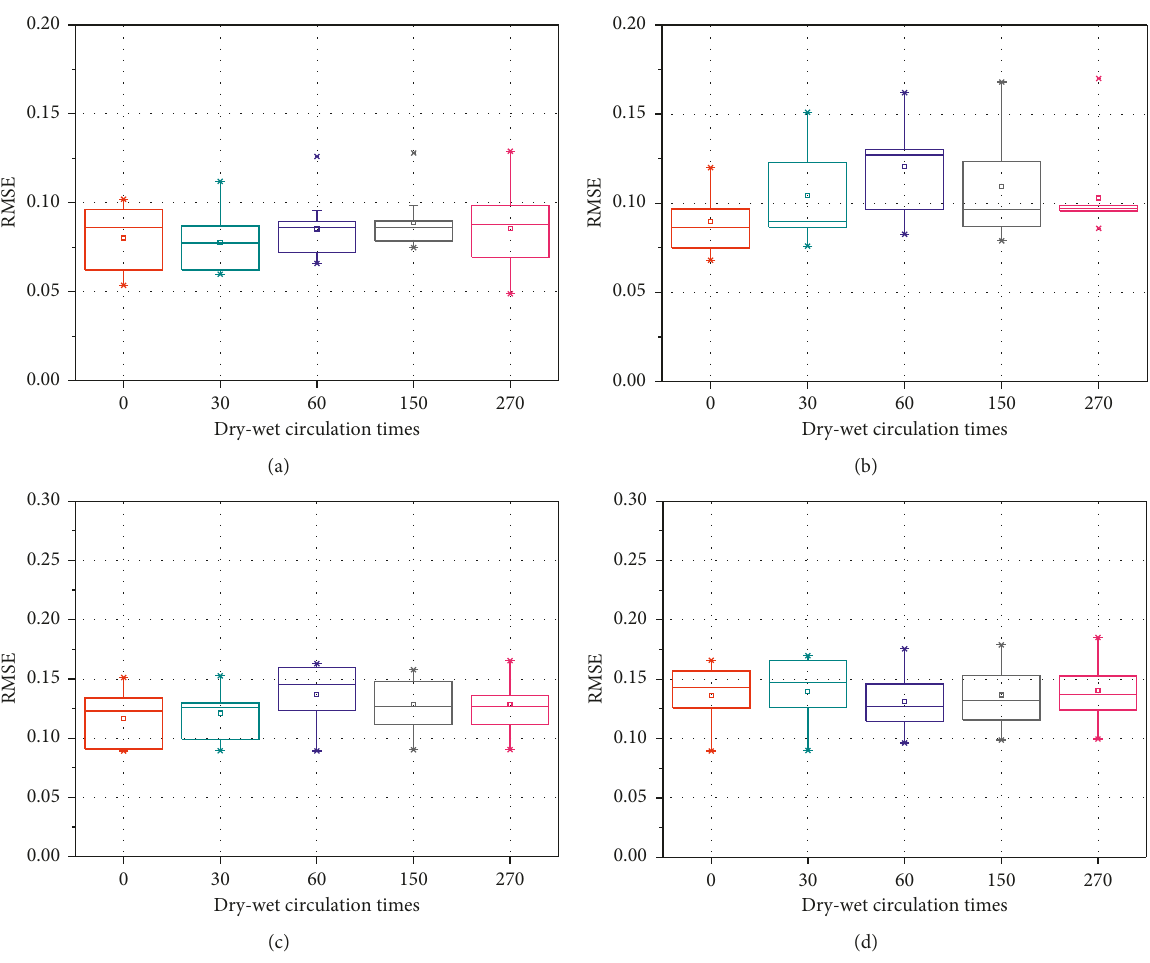
Figure 7: Percentile box figure with the analysis index of RMSE for (a) the double exponential model, (b) the Weibull model, (c) the first- order process, and (d) the zero-order